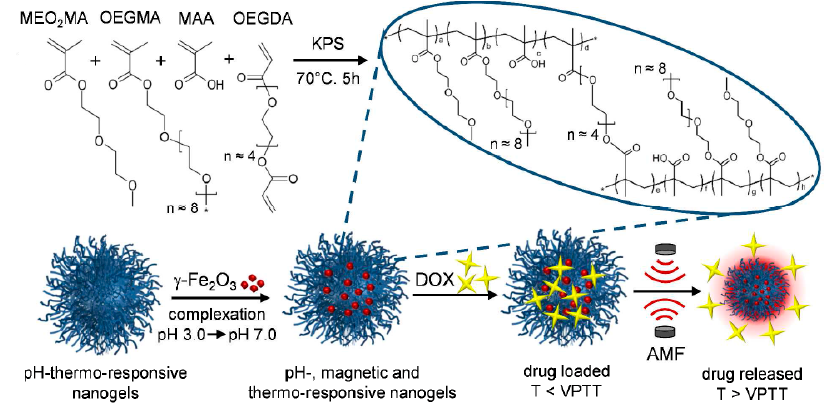
Figure 9. Temperature- and magnetic-field-responsive nanogels based on OEGMA for intracellular remote release of DOX. Adapted from Ref. [164] reproduced by permission of American Chemical Society.